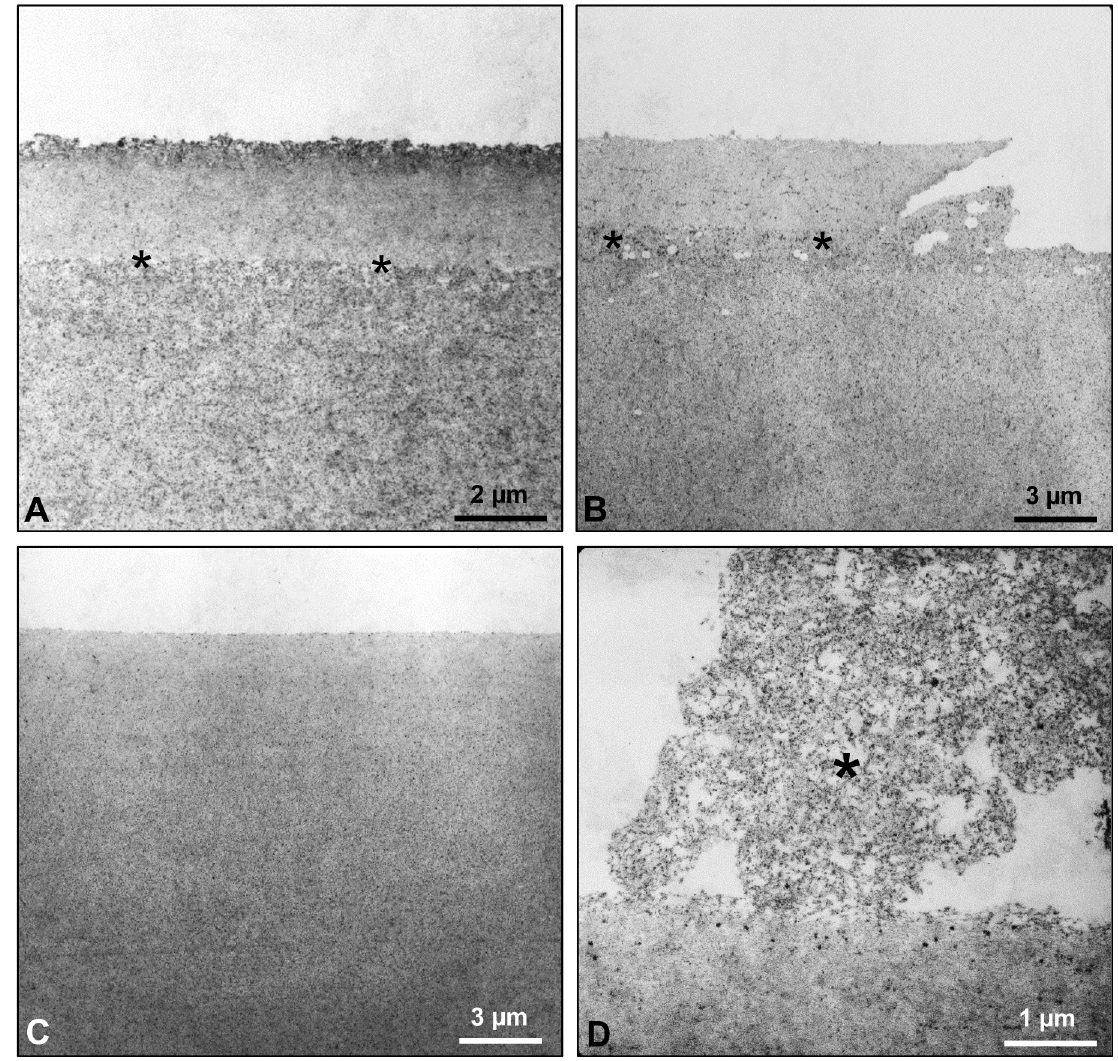
Fig 6. Transmission electron micrographs of lens capsule specimens showing various alterations of the capsular surface. (A, B) Layer formation within the superficial capsule with a vacuolar interface (asterisks) between layers. (C) Smooth and compact capsular surface. (D) Precursor PEX material (asterisk) on the capsule